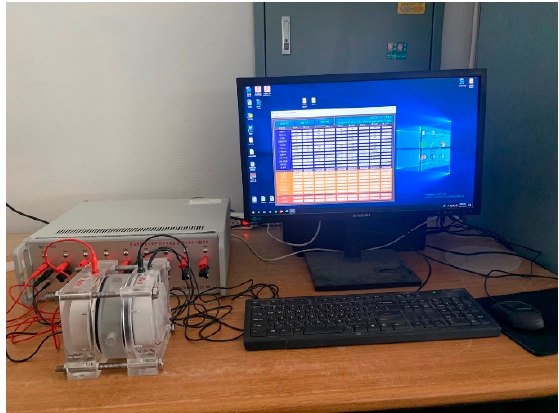
Figure 3. Chloride-ion penetration test.